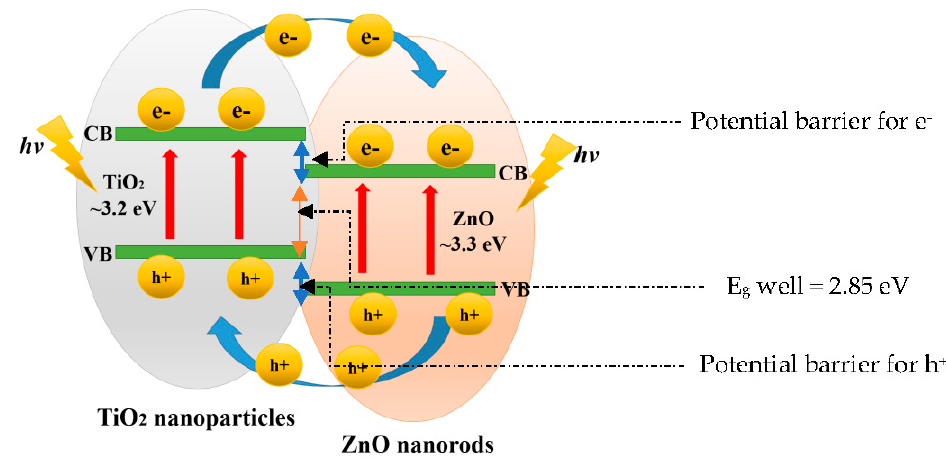
Figure 17. Illustration of staggered bandgap (type II) TiO 2 loaded on ZnO nanorod semiconductor and its photo-induced charge transfer and separation.